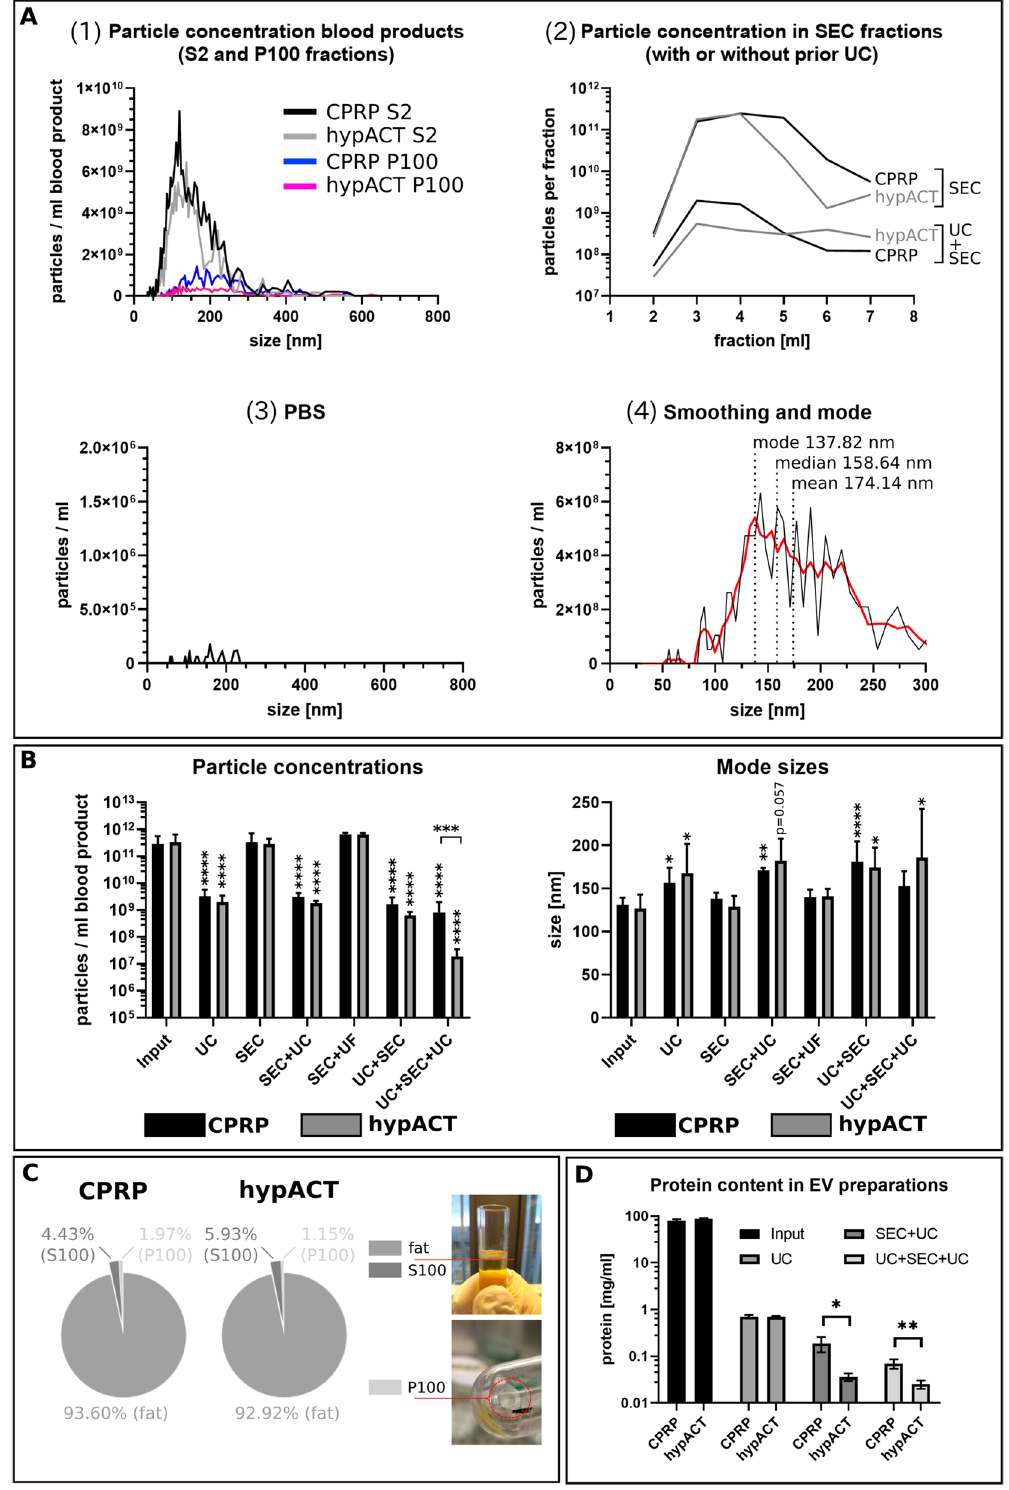
Figure 2. Particle concentration, mode sizes and protein concentrations of isolated EVs from CPRP and hypACT. ( A ) (1), representative size profiles of S2 and P100 fractions; (2), particle concentrations in SEC fractions with or without prior UC; (3), size profile of PBS control and (4), representative result of smoothing the raw size distribution via the Savitzky-Golay approach as described and comparison of mode, median and average particle size of a particle population as determined via NTA. ( B ) Particle concentrations and mode sizes in input and after indicated EV preparation procedures. Data from at least three biological replicates are given ± SD. ( C ) Evaluation of particle content after UC of S2 fraction in fat layer, S100 and P100 fractions, adapted from 21 . Data from three biological replicates are given as mean percentages of sum of particles in all fractions. ( D ) Protein concentration in input material and EV preparations obtained via the indicated procedures, normalised to input volume. Data from at least three biological replicates are given ± SD.* p < 0.05, ** p < 0.01, *** p < 0.001, **** p <